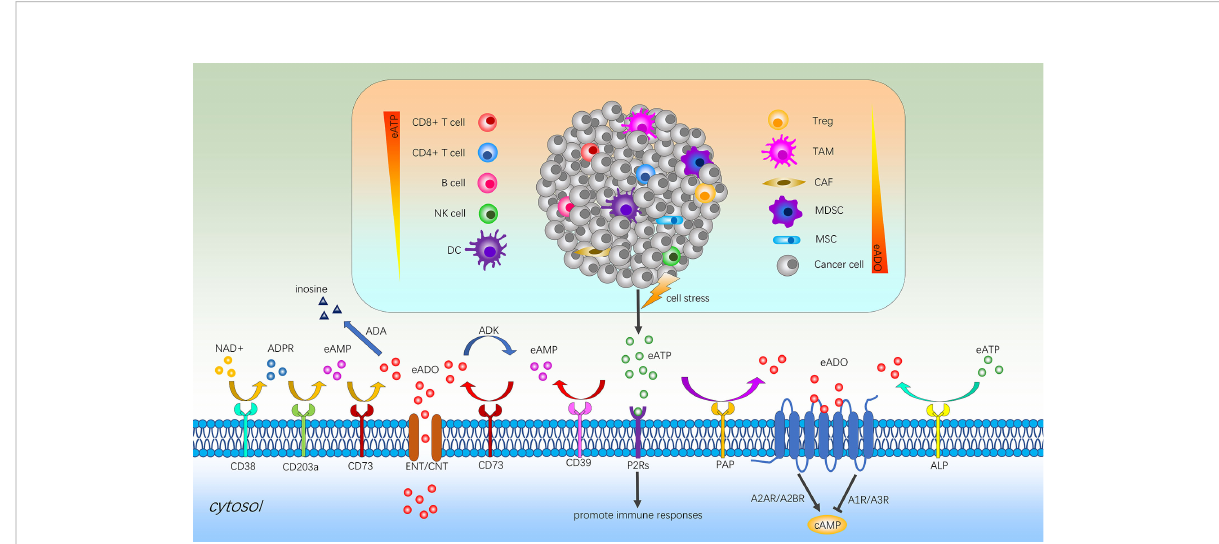
FIGURE 4 Immune regulation of adenosine signaling in the TME. Cell stress promotes eATP production and contributes to chronic in fl ammation via P2Rs. Within the TME, accumulated eATP can be degraded to ADO by the sequential action of the ectonucleotidases CD39 and CD73 or other alternative pathways such as ALP or PAP-mediated process. In addition, the sequential catabolism of NAD + by CD38, CD203a and CD73 also can generate ADO and the high concentration of intracellular ADO can be transported outside the cell via ENTs or CNTs to maintain balance. The bioavailability of extracellular ADO is regulated by adenosine-converting enzymes such as ADK and ADA, which converts ADO into AMP and inosine respectively. High concentrations of ADO binding to adenosine receptors to inhibit the activation of immune cells and stimulate immunosuppressive cells to promote the immune escape of cancers. eATP, extracellular adenosine triphosphate; eAMP, extracellular adenosine monophosphate; NK cell, natural killer cell; DC, dendritic cell; Treg, regulatory T cell; TAM, tumor-associated macrophage; CAF, cancer associated fi broblast; MDSC, myeloid-derived suppressor cell; MSC, mesenchymal stromal cell; ADO, adenosine; NAD + , nicotinamide adenine dinucleotide; ADPR, adenosine diphosphate ribose; ADA, adenosine deaminase; ADK, adenosine kinase; ENT, equilibrative nucleoside transporter; CNT, concentrative nucleoside transporter; P2Rs, P2 purinergic receptors; PAP, prostatic acid phosphatase; ALP, alkaline phosphatase; cAMP, cyclic adenosine